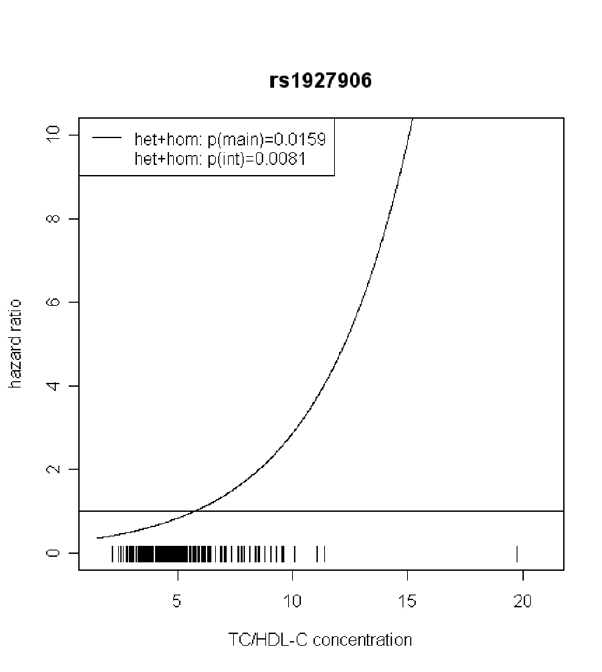
Figure 8 Hazard ratios of incident type 2 diabetes related to the respec- tive TC/HDL-C concentration in men for rs1927906 . Continuous lines represent subjects who are heterozygote or homozygote for the minor allele. Small bars at the x-axis indicate TC/HDL-C concentrations of patients with at least one copy of the minor